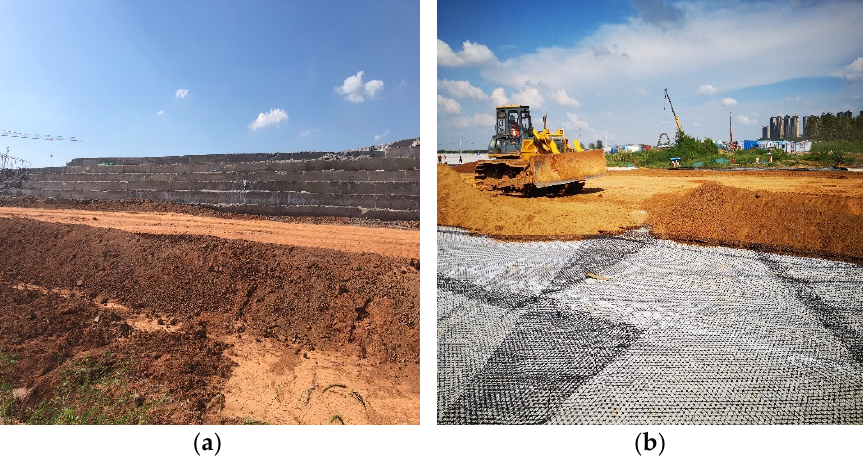
Figure 8. On-site maintenance: ( a ) edge compacted with cemented soil and ( b ) top layer with plastic grating and cemented soil.